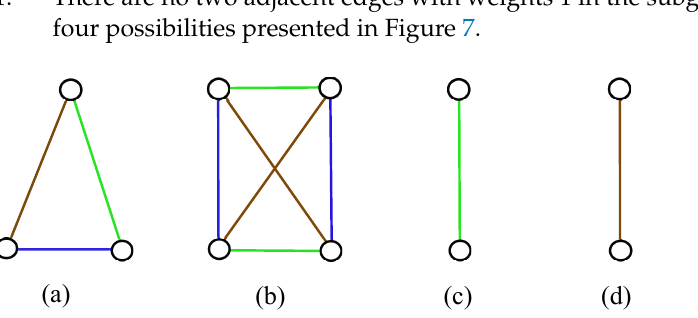
Figure 7. Four possible components of the subgraph G D in which there are no two adjacent edges with weights 1. Green, blue, brown, and black correspond to the values 1, 2, 3, and 4, respectively. ( a ): the complete graph K 3 with edge weights 1, 2, and 3; ( b ): the complete graph K 4 with edge weights 1, 1, 2, 2, 3, and 3; ( c ): the complete graph K 2 with edge weight 1; ( d ): the complete graph K 2 with edge weight 3.